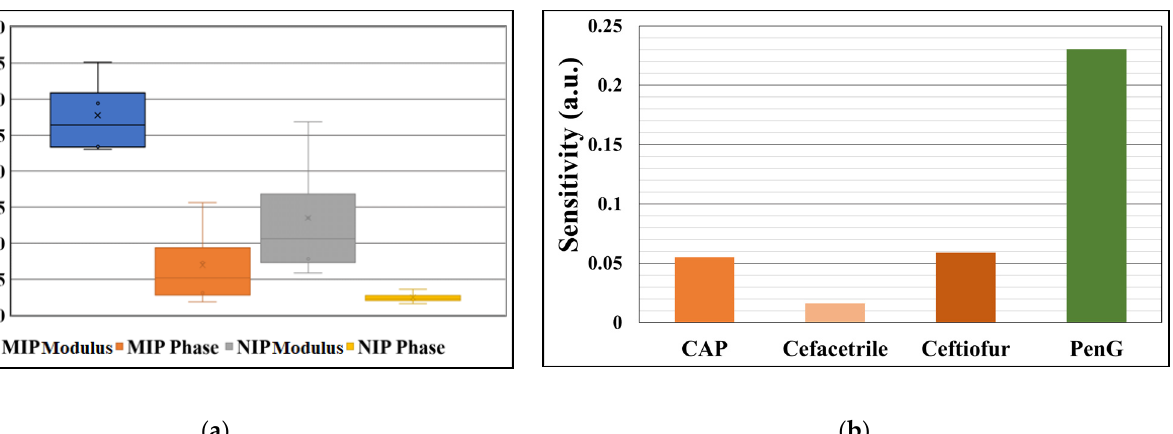
Figure 9. Sensitivity of the different MIP and NIP sensors, in phase and modulus, for various sensors exposed to a 15 ppb PenG variation (n = 5) ( a ); Sensitivity measured in modulus for various interferents for MICP sensors at 15 ppb concentrations (comparison with PenG on the right) ( b ).